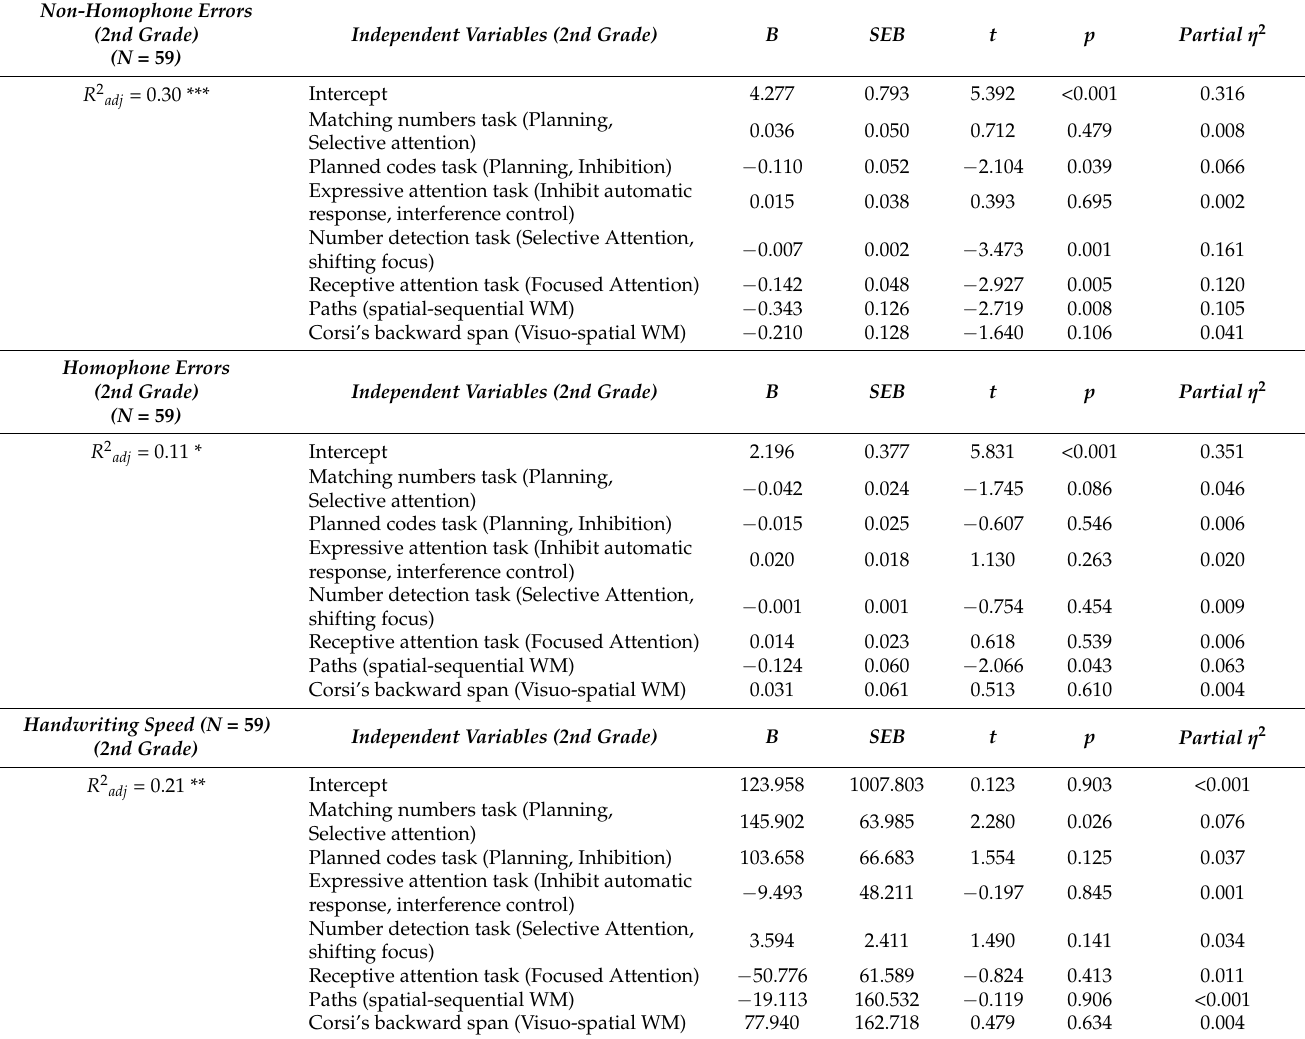
Table 4. Summary of the regression model for the first data collection: regression parameter B, standard error of B (SEB), Student’s t-test (t), p -value, and partial eta-squared (Partial η 2 ). Non-Homophone Errors (2nd